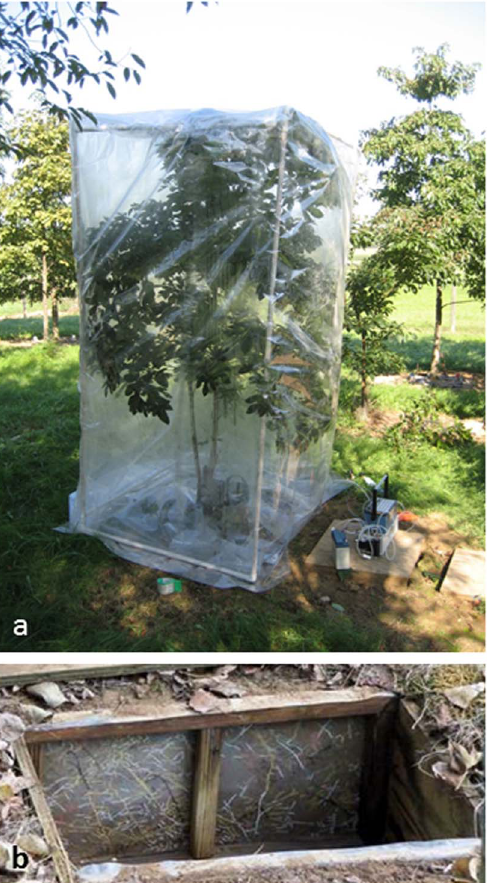
Figure 1. Methods used in study. A . Sassafras albidum tree covered in a clear mylar balloon during the 13 CO 2 labeling process. B . Example of a root box showing roots that were traced on a clear acetate window facing the study tree using different color paint